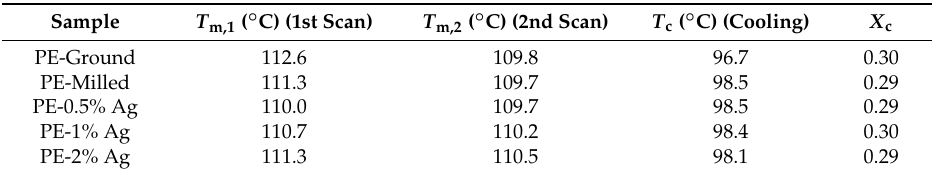
Table 1. Melting temperatures obtained from the first heating ( T m,1 ) and second heating ( T m,2 ) scan, crystallization temperature ( T c ) and crystallization degree ( X c ).